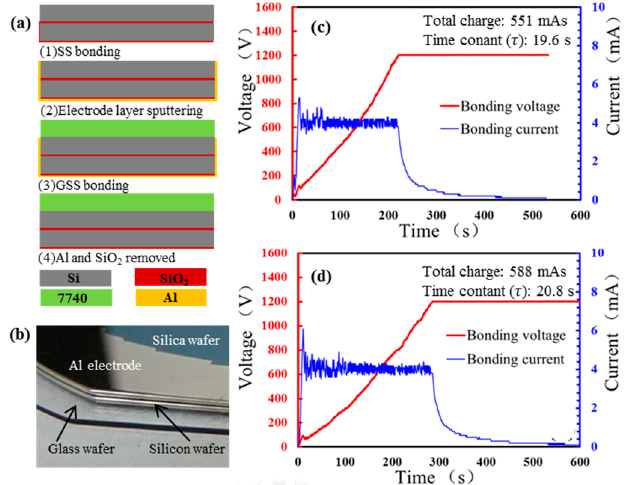
Figure 4. An experimental bonding process was conducted to verify the correctness and feasibility of the cross-layer anodic bonding. ( a ) The Schematic of the test process; ( b ) The bonding result of the cross-layer anodic bonding; ( c ) The anodic bonding electrical characters of the GSS cross-layer anodic bonding; ( d ) The anodic bonding electrical characters of the GS anodic bonding.